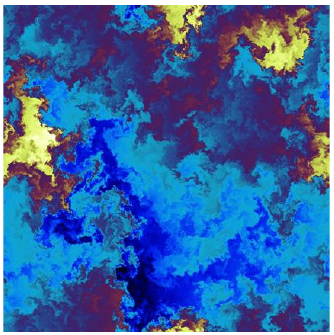
Figure 6: Concentration field 𝑐 ( 𝑥, 𝑦 ), at a given time, on the plane ( 𝑥, 𝑦 ). The field has been obtained by a numerical simulation at resolution 2048 (cid:214) 2048. The concentration is treated as a passive scalar, transported by a turbulent field. Low concentrations are reported in blue while high concentrations are reported in yellow (courtesy by A. Noullez).